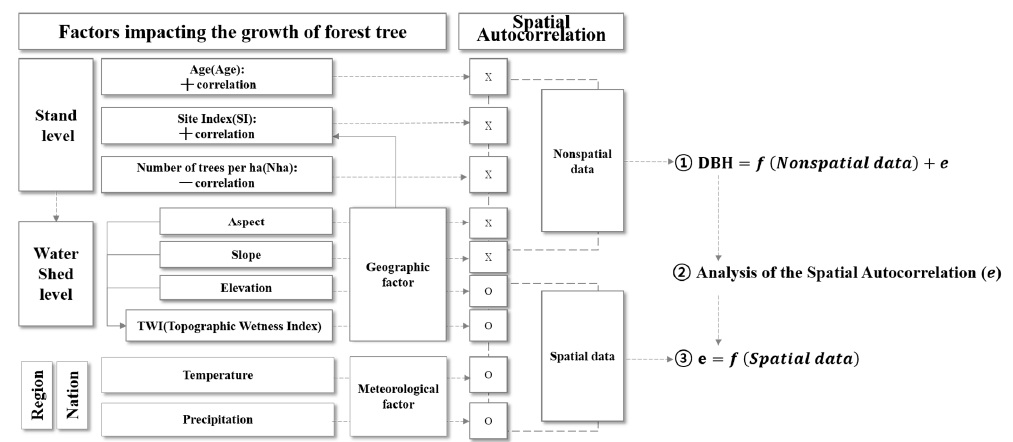
Figure 3. Hypothesis for developing the diameter at breast height (DBH) model in this study. “x” and “o” represent the absence and presence of spatial autocorrelation, respectively.